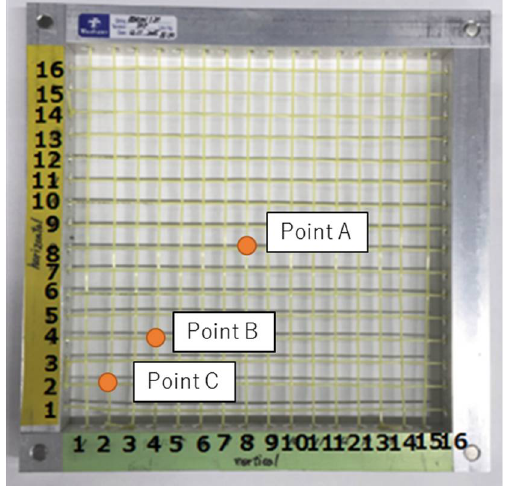
Figure 6. String-bed specimen; string interval is 12 mm.